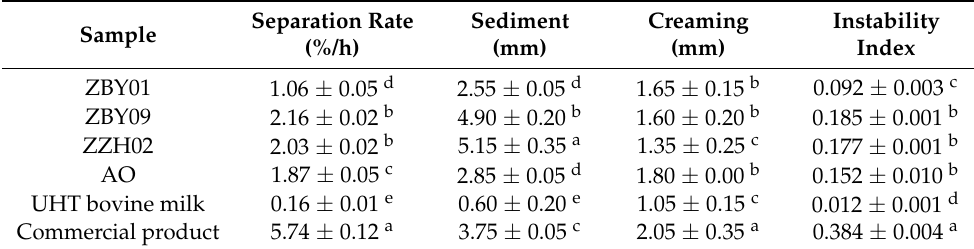
Table 3. Stability of oat milk produced by different cultivars, commercial product, and UHT bovine milk.